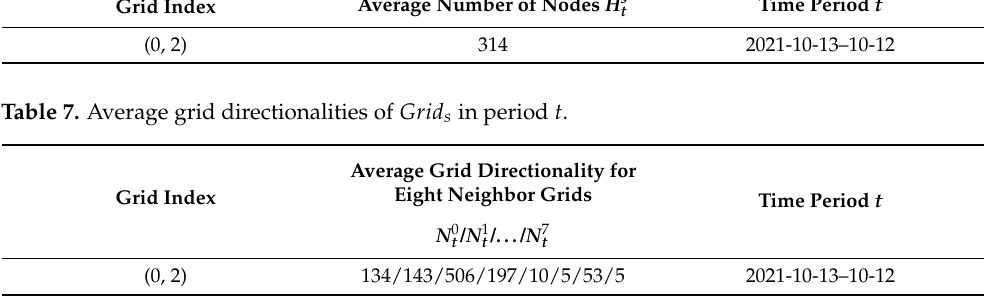
Table 5. Average number of outgoing nodes of road segment i in period t , if road segment i crosses